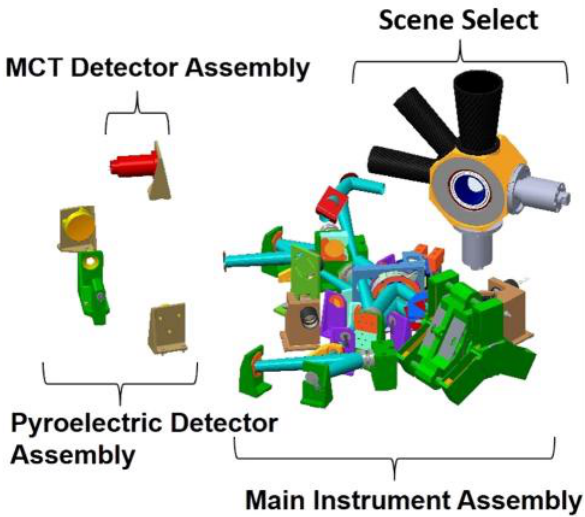
Figure 4. Accuracy of decadal trends of current earth observing missions and the potential improvement CLARREO will yield (Wielicki 2013)